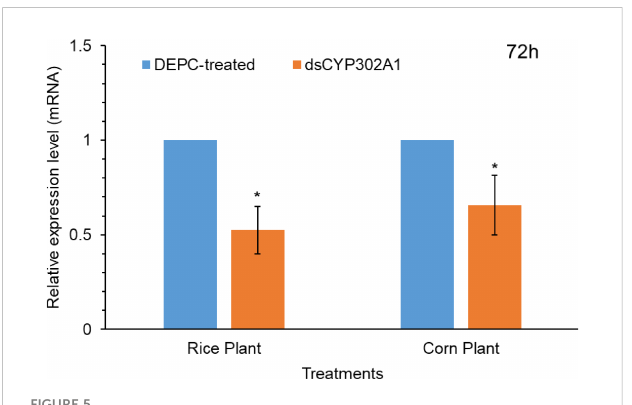
FIGURE 5 The relative mRNA transcript levels in the midguts of S. frugiperda larvae after feeding on dsCYP302A1 DEPC-treated water for 72 h. Data shown are mean ± SE. Treatments were compared using Student ’ s t test. * represent P < 0.05.